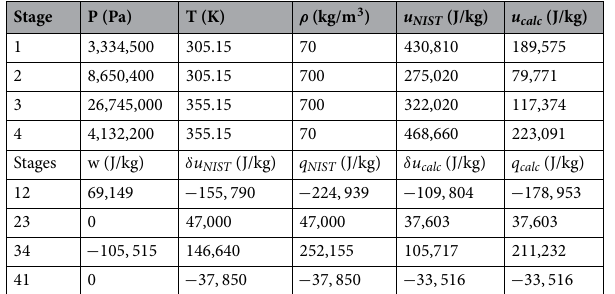
Table 1. The stages of the non-ideal Stirling cycle heat engine, as well as the specific work inputs and outputs w (J/kg), specific heat inputs and outputs q (J/kg), and specific internal energies u (J/kg) from both NIST 54 and calculated calc with Eq. (4).